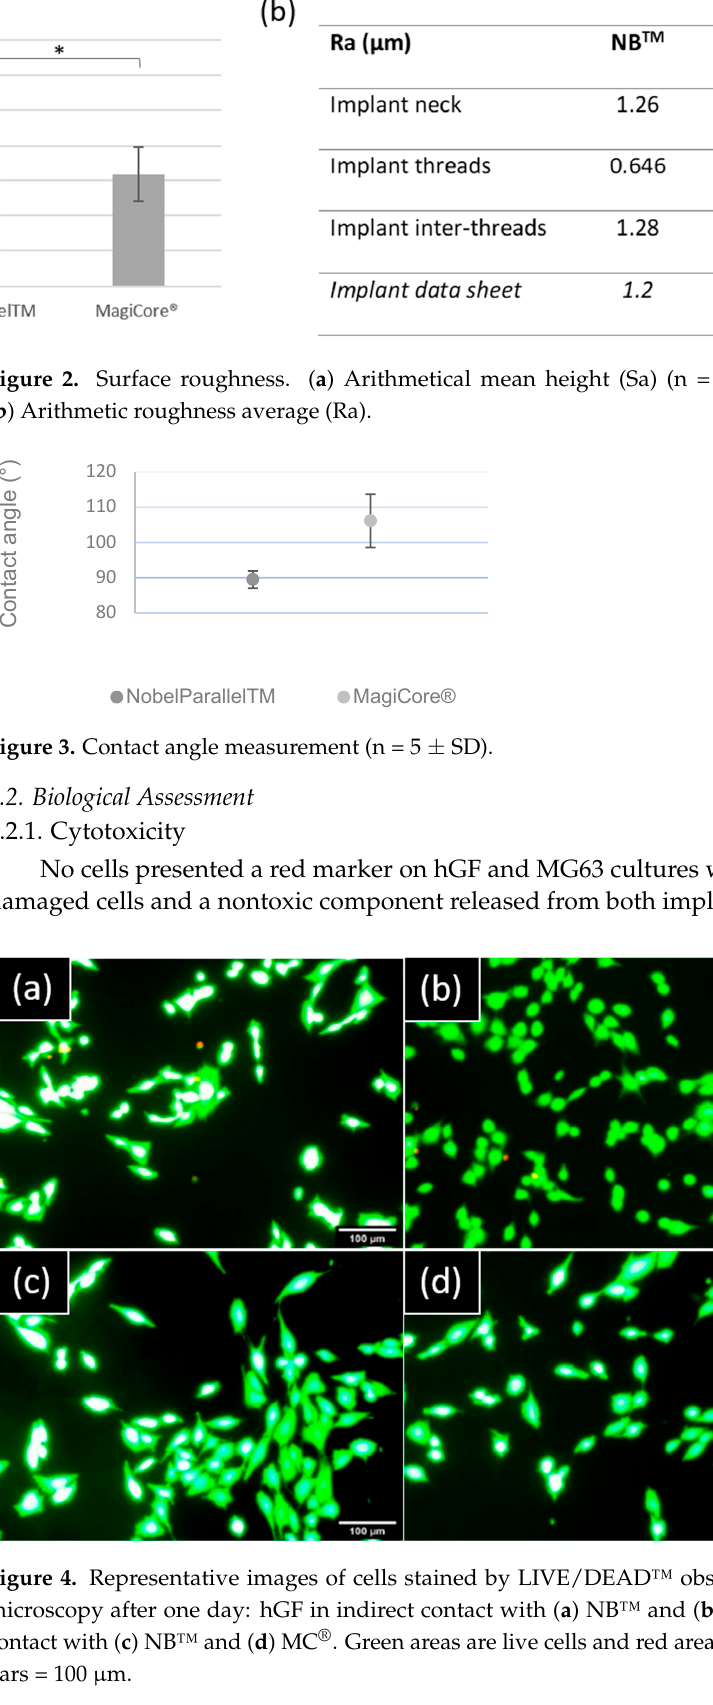
Figure 2. Surface roughness. ( a ) Arithmetical mean height (Sa) (n = 5 ± SD, * p < 0.05) and ( b ) Arith- metic roughness average (Ra).